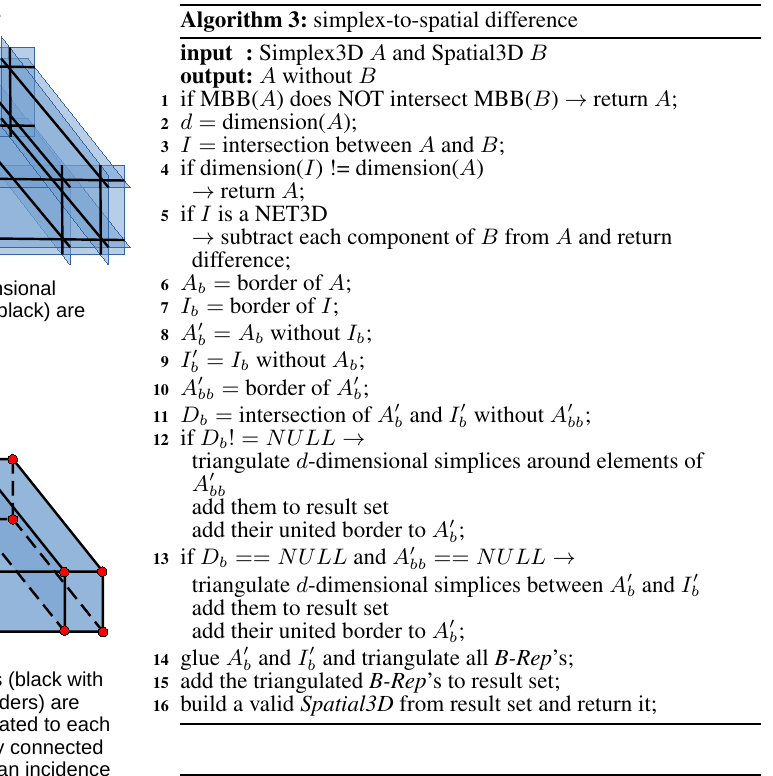
Algorithm 4: Small bite by sweep